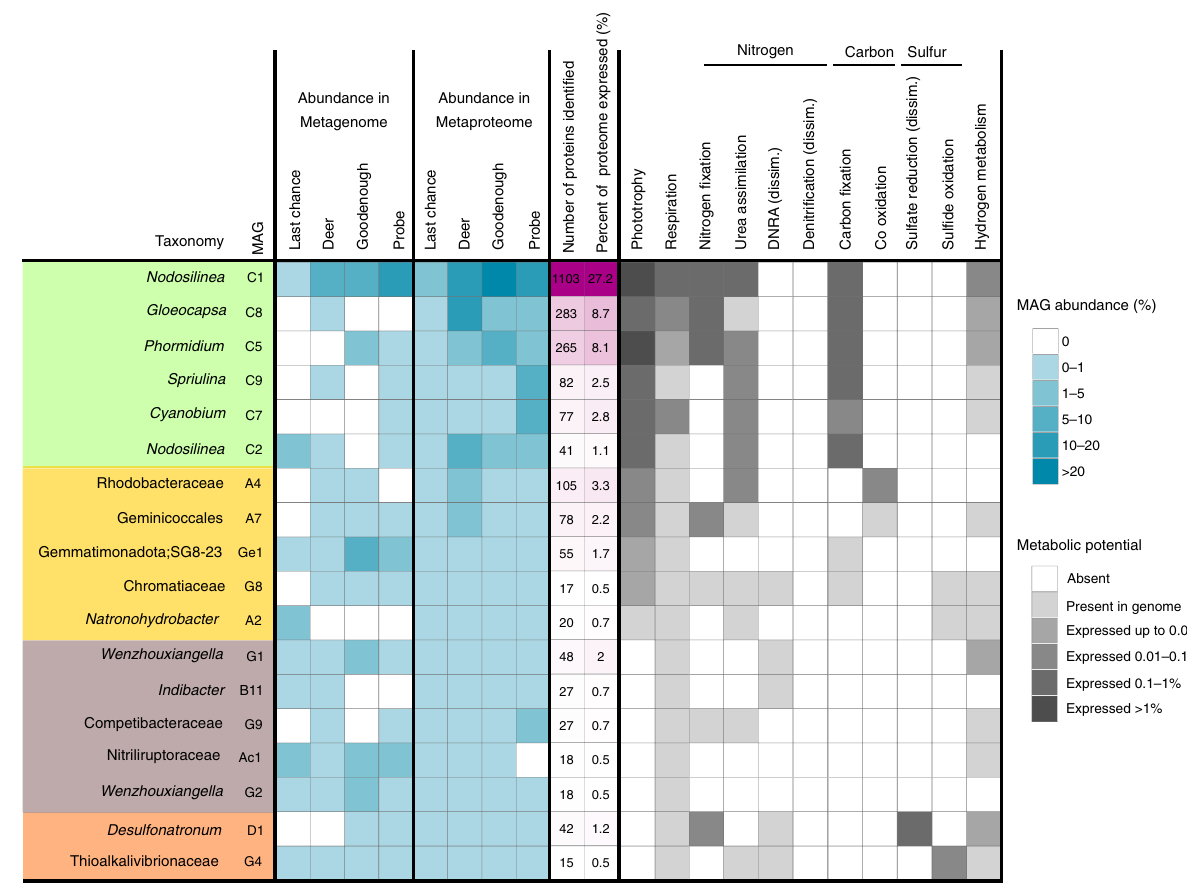
Fig. 3 Summary of metabolism and protein expression of soda lake populations. Heatmap showing abundances and expressed functions for metagenome- assembled-genomes (MAGs) with at least 15 proteins identi fi ed in the metaproteomes. MAGs are broadly arranged based on function, with photoautotrophs in green, anoxygenic phototrophs in yellow, sulfur cycling in orange, and other heterotrophic bacteria in brown. Metabolic potential was inferred from the genes listed in Supplementary Data 6. If the gene was identi fi ed in a metaproteome it was considered expressed, and is shaded according to its highest relative abundance (% of all peptide spectral matches) in the four lake metaproteomes. MAG abundances in metagenome and metaproteome were estimated as explained in Materials and